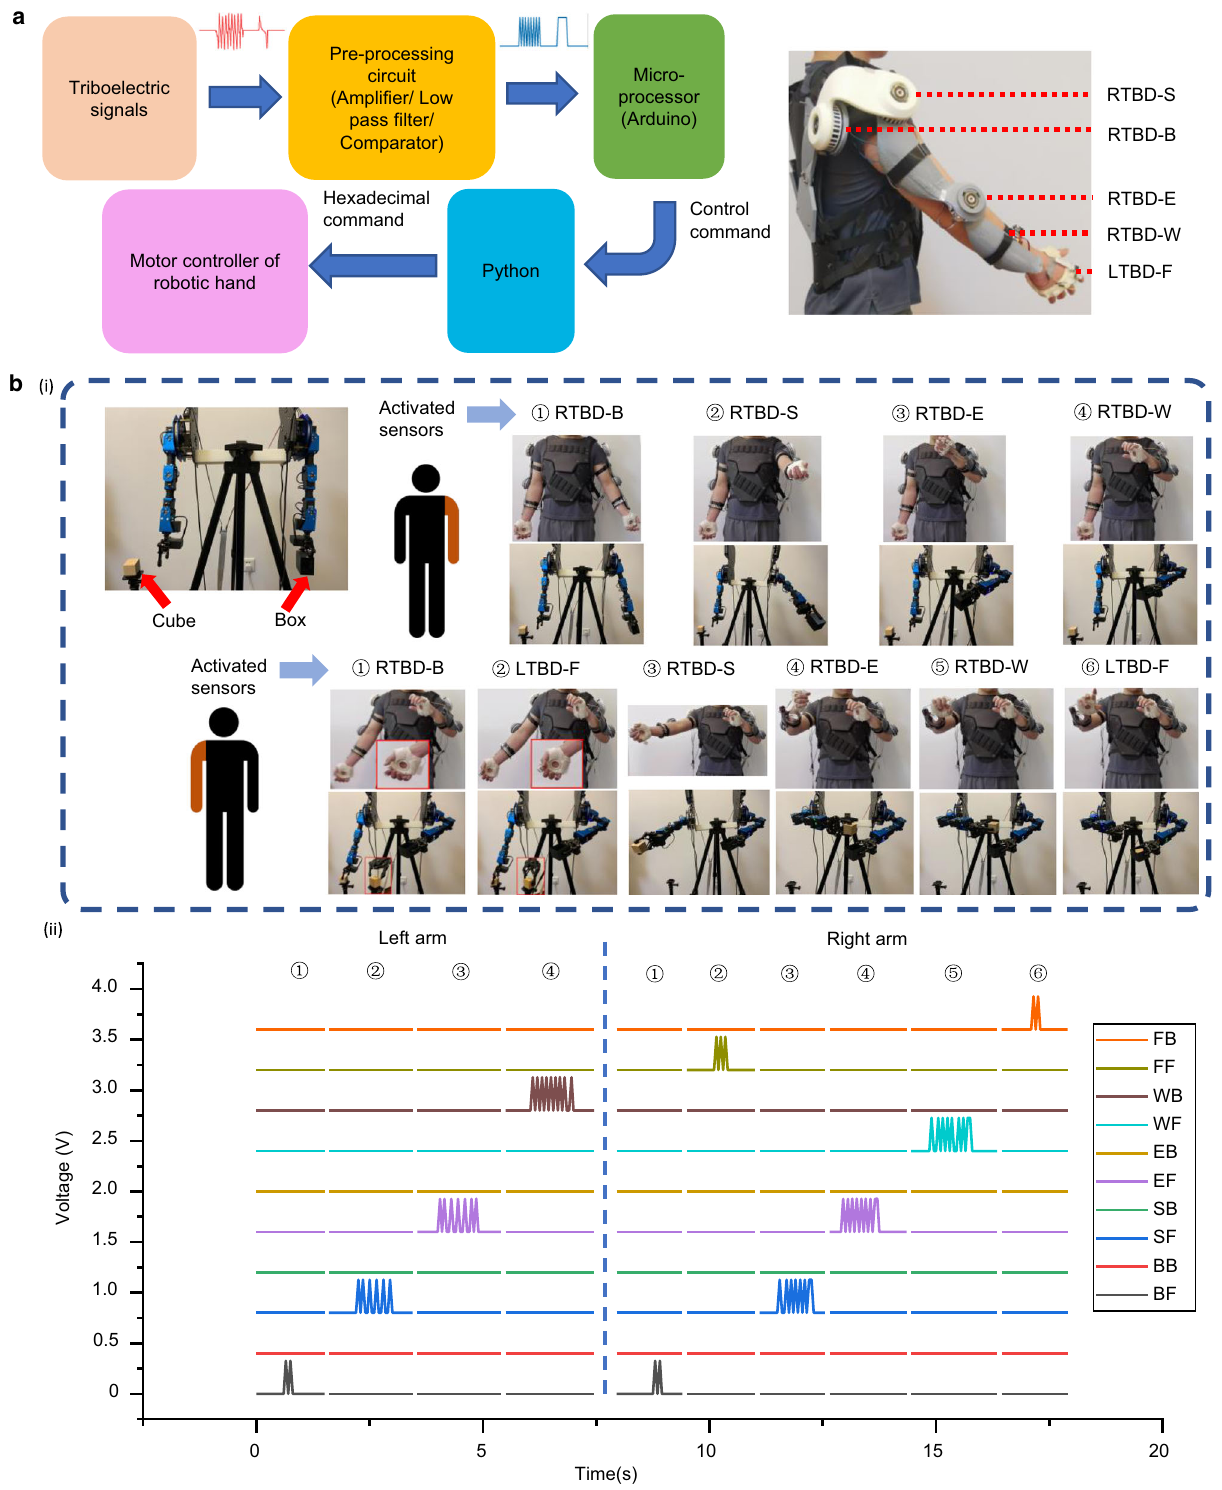
Fig. 4 Signal processing and demonstration in robotic control. a Flow chart of triboelectric signal processing for manipulation of robotic arms, and the photograph of the exoskeleton sensory system (right arm) with the rotational triboelectric bidirectional back (RTBD-B) sensor, the rotational triboelectric bidirectional shoulder (RTBD-S) sensor, the rotational triboelectric bidirectional elbow (RTBD-E) sensor, the rotational triboelectric bidirectional wrist (RTBD-W) sensor, and the linear triboelectric bidirectional fi nger (LTBD-F) sensor. b Demonstration of joint works of two robotic arms for picking up the cube and placing it into the box, (i) fl ow chart of the motions, and the activated arm and the sensors. (ii) the real-time signals during the manipulation, the channels of BF, BB, SF, SB, EF, EB, WF, WB, FF, and FB represent the forward (clockwise) and the backward (counterclockwise) rotations of the RTBD-B sensor, the RTBD-S sensor, the RTBD-E sensor, the RTBD-W sensor, and the LTBD-F sensor. Photo credit: Minglu Zhu, National University of